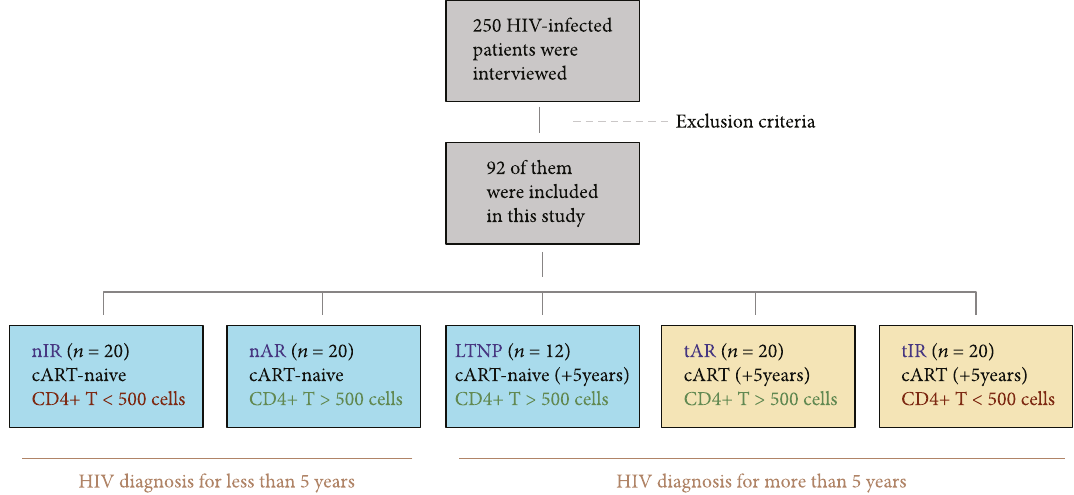
Figure 1: Flowchart for patients ’ inclusion and division into study groups, according to the presence or not of combined antiretroviral therapy (cART), CD4 + T cells count (cells/mm 3 ), and time of HIV